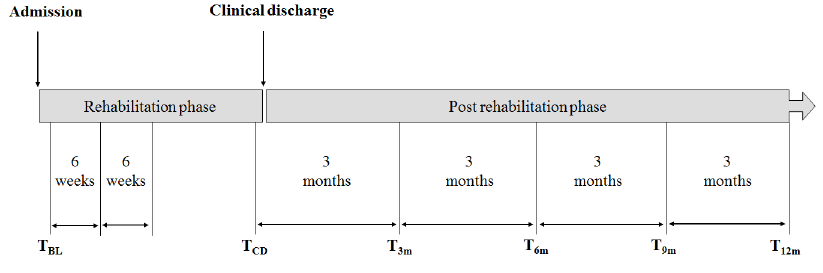
Fig 1. Overviewof measurement timing. T = time; BL = baseline;CD = clinicaldischarge;m = month.